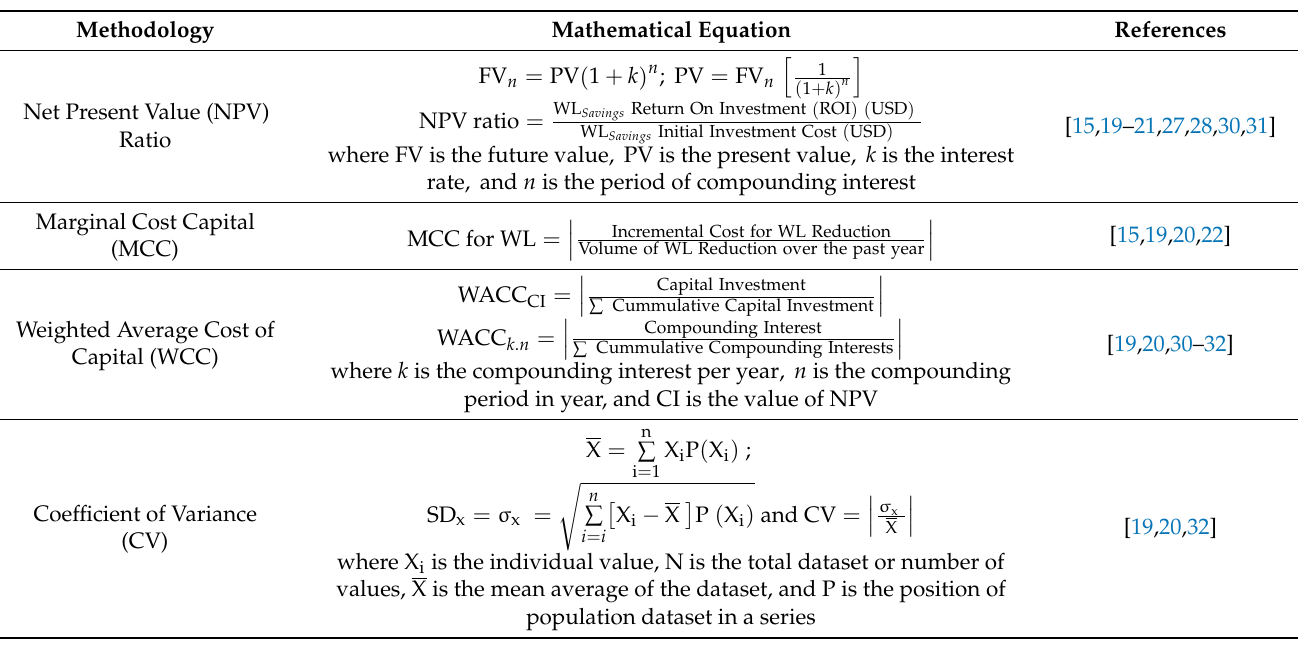
Table 1. Mathematical formulations for the computation and derivation of the cost–benefit analysis indexes.